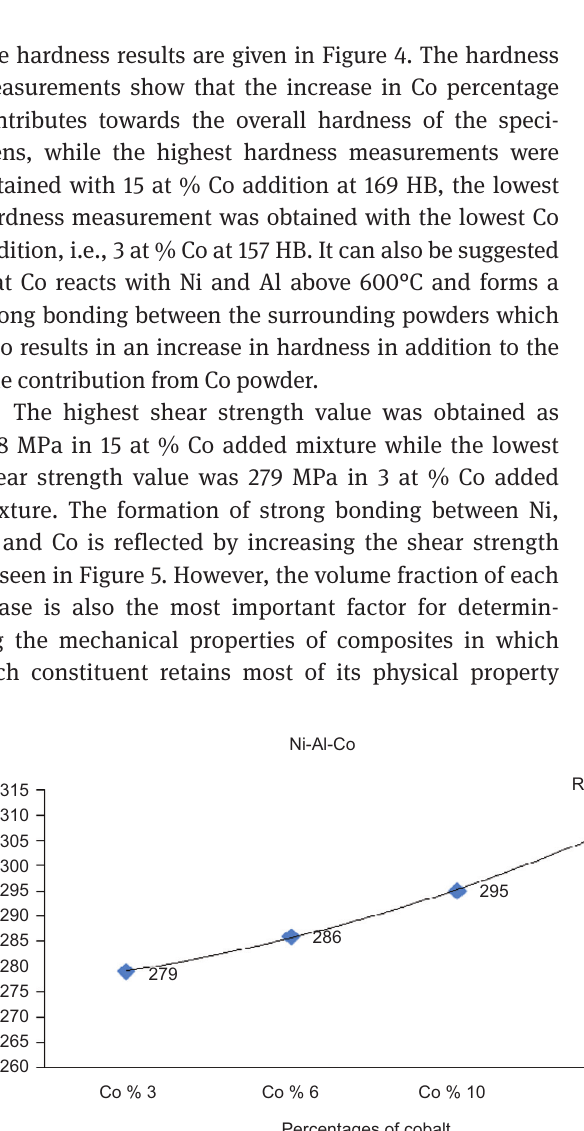
Figure 4 Hardness results from Ni+Al+Co composite materials.